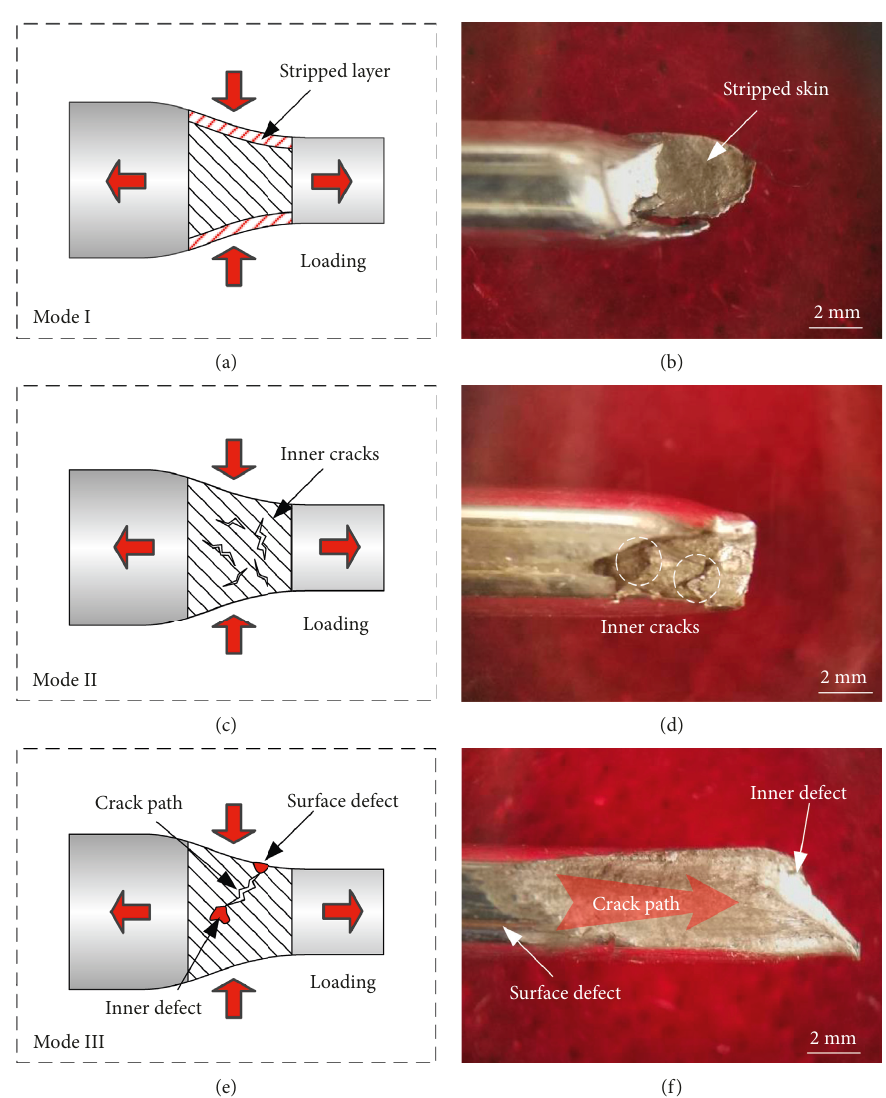
Figure 3: Schematic diagram and macroscopic morphology of three fracture modes: (a) Model I: stripped layer; (b) macroscopic fracture corresponding to (a); (c) Model II: internal cracks; (d) macroscopic fracture corresponding to (c); (e) Model III: crack penetrating the surface and the interior; (f) macroscopic fracture corresponding to (e).